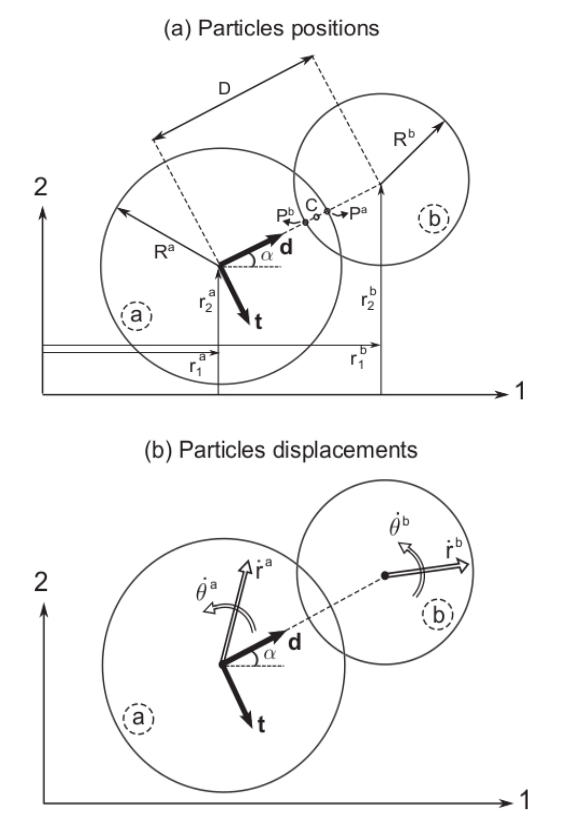
Figure 2: The interaction of the two particles by the force– displacement law. The figure is redrawn from Ferdowsi (2014). Particles a and b of radii R and R are at a distance D with overlap a b C. P and P are the points of intersection of the line connecting a b the disc centres with the boundaries of the discs; d and t are unit vectors. Derivatives of r and θ stand linear damping and rotational damping,